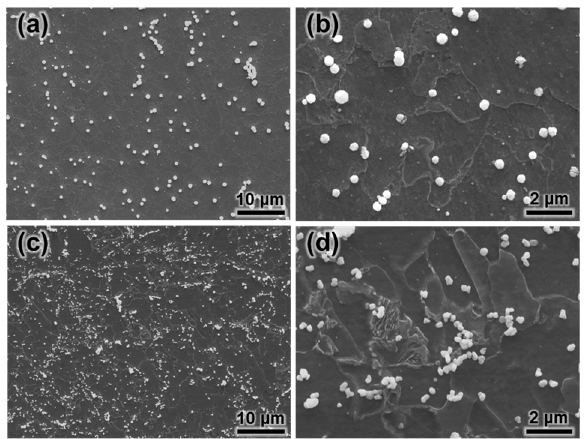
Figure 6. SEM images of X65 steel with different cold deformation levels after hydrogen microprinting: ( a , b ) without cold deformation (0.00%), ( c , d ) with 7.25% cold deformation.